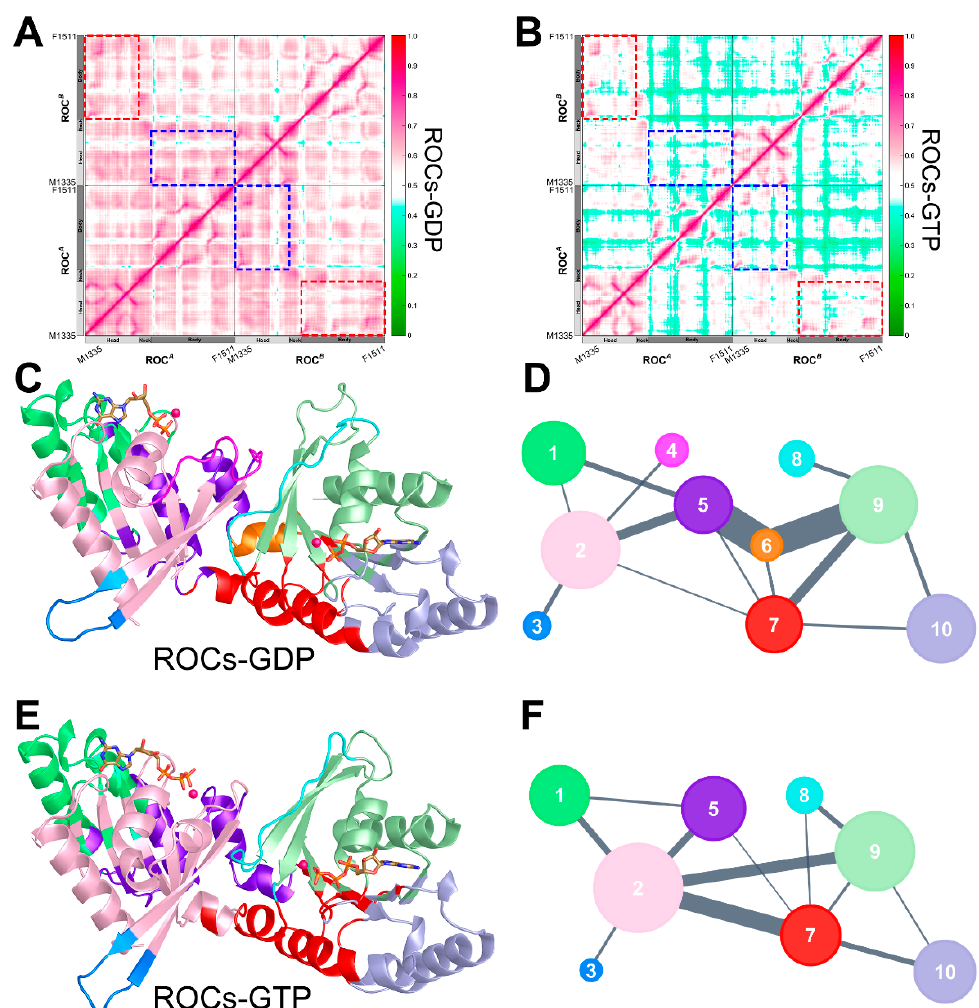
Figure 4. Generalized cross correlation matrix (GCCM) of ( A ) ROCs-GDP and ( B ) ROCs-GTP. The colormap used for the graph is shown on the right with no/weak correlations indicated in green and strong ones in magenta. The correlation between ROC A head and ROC B body, and that between ROC A body and ROC B head subdomain, is highlighted in red and blue dashed line rectangles, respectively. Cartoon representation of ( C ) ROCs-GDP and ( E ) ROCs-GTP color-coded based on their corresponding community structures. Simplified community network map with inter-community crosstalk in ( D ) ROCs-GDP and ( F ) ROCs-GTP. Each community in the original structure is reduced to a sphere whose area is proportional to the residue components. Inter-community crosstalk is visualized by sticks of width that are proportional to edge connectivity between communities.